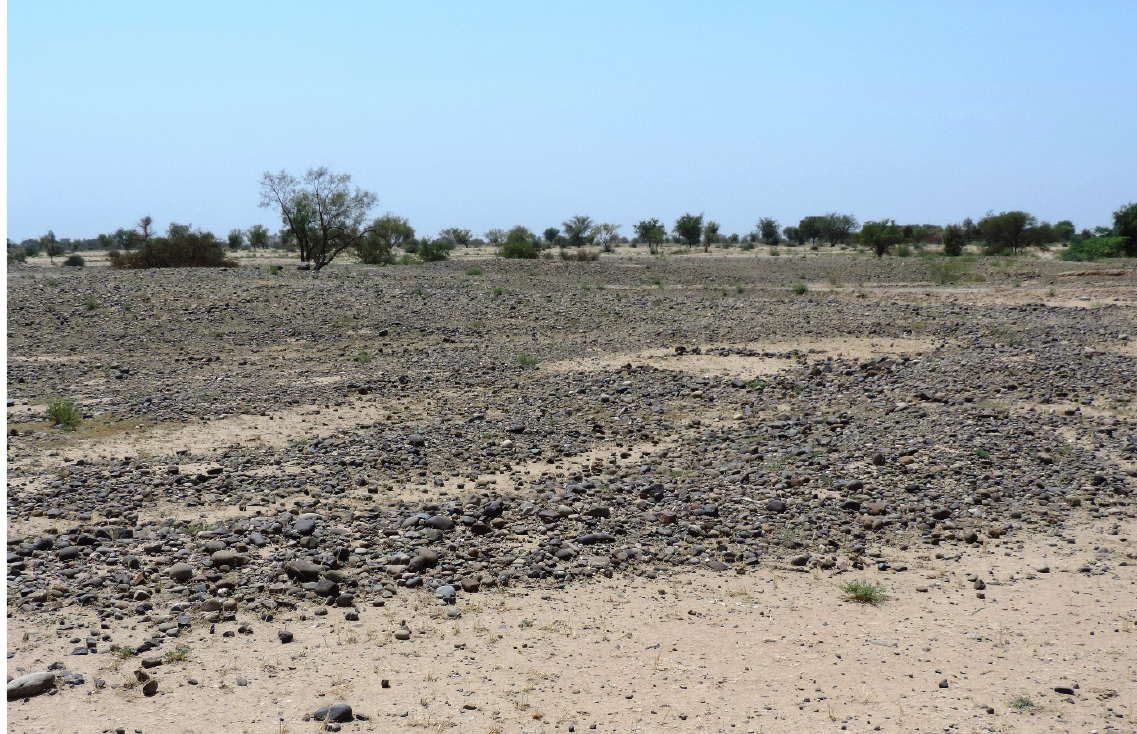
Figure 2. Dark grey and black varnished gravel terraces south of the course of Barrai Khuarra (photograph by R. Nisbet,